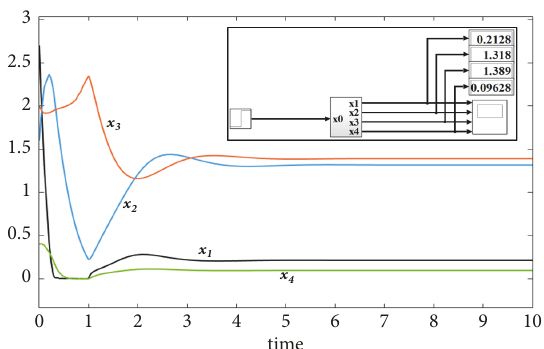
Figure 6: ( 4 g ene s ) simulation results of Case 3 in Table 2.